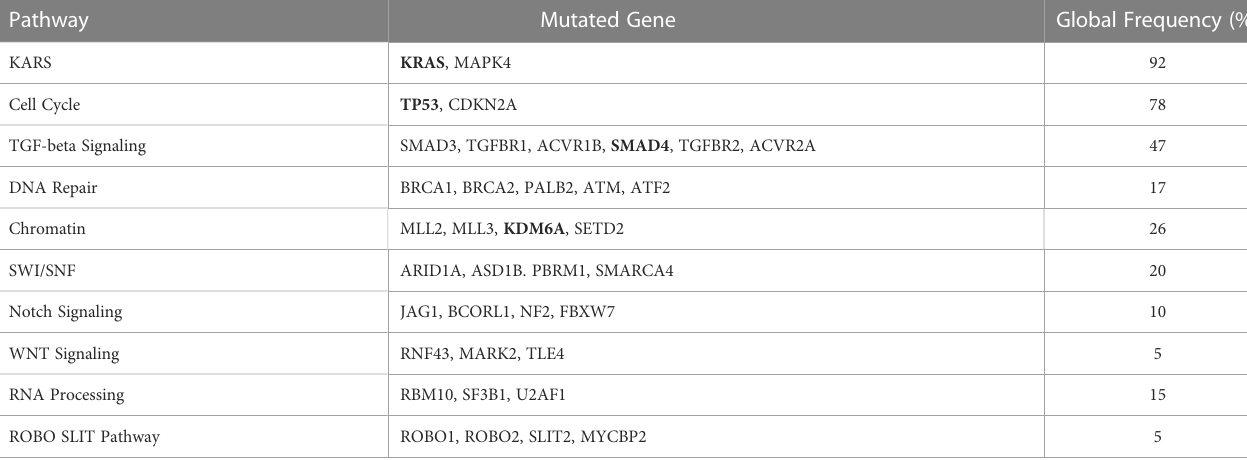
TABLE 1 The list of mutated genes and the related pathways in pancreatic cancer (PC).